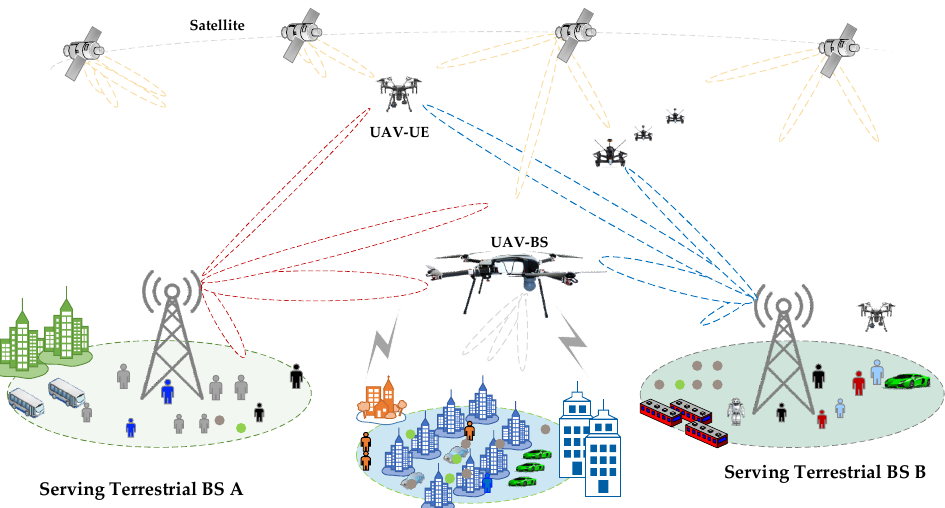
Figure 7. The antenna beam pattern and antenna sidelobes effect.